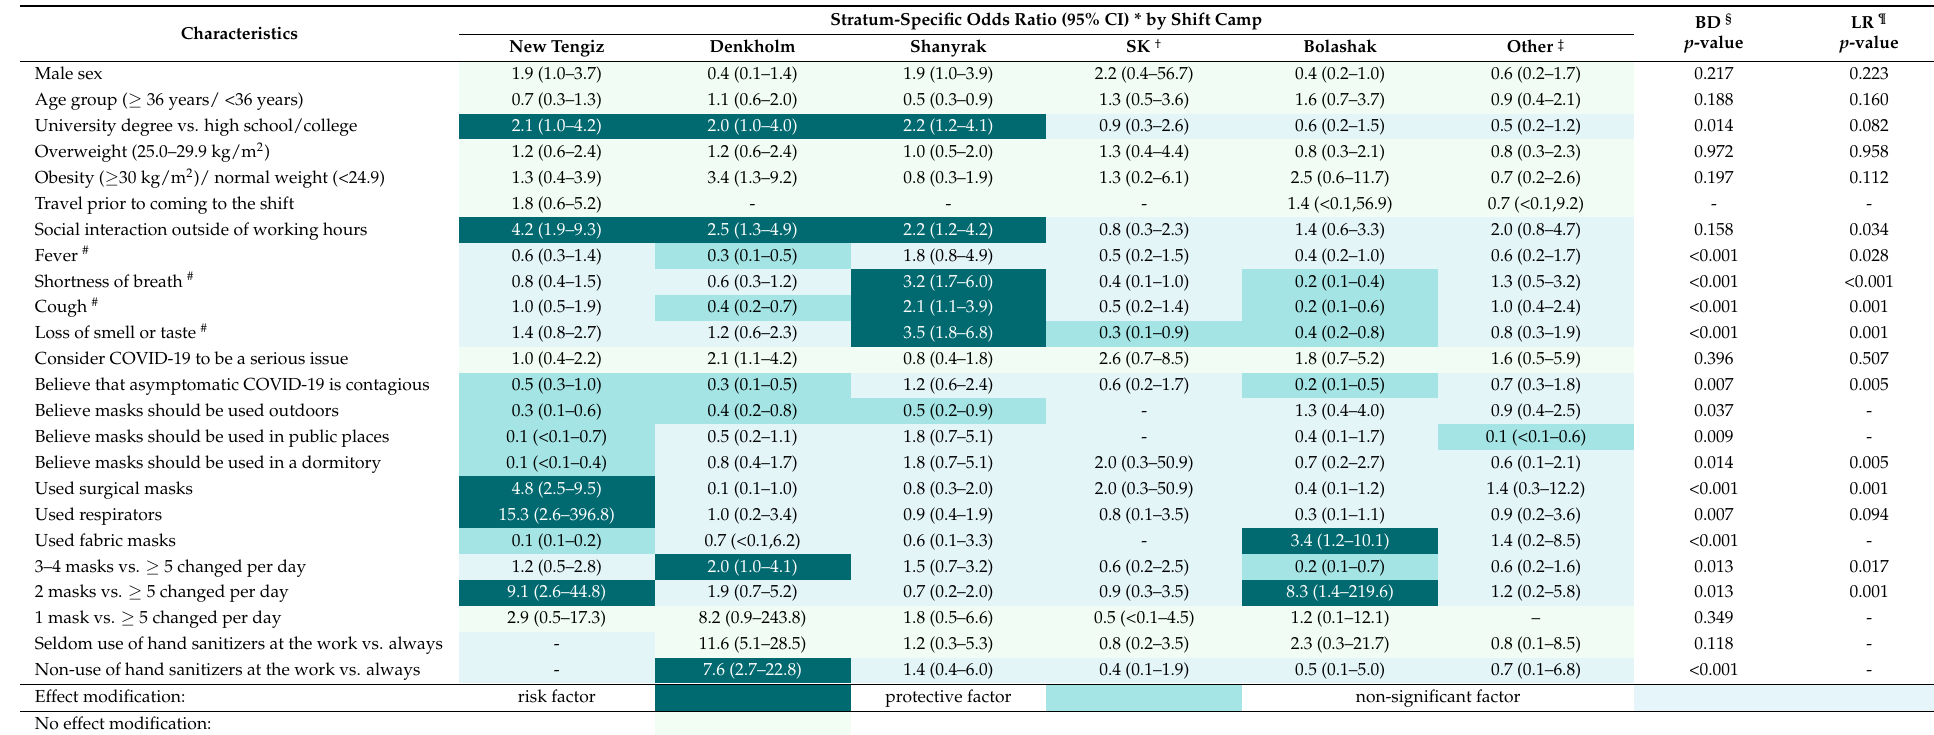
Table A1. Stratified analysis of individual factors associated with novel coronavirus disease in shift camps in Tengizchevroil, Kazakhstan during June–September 2020.